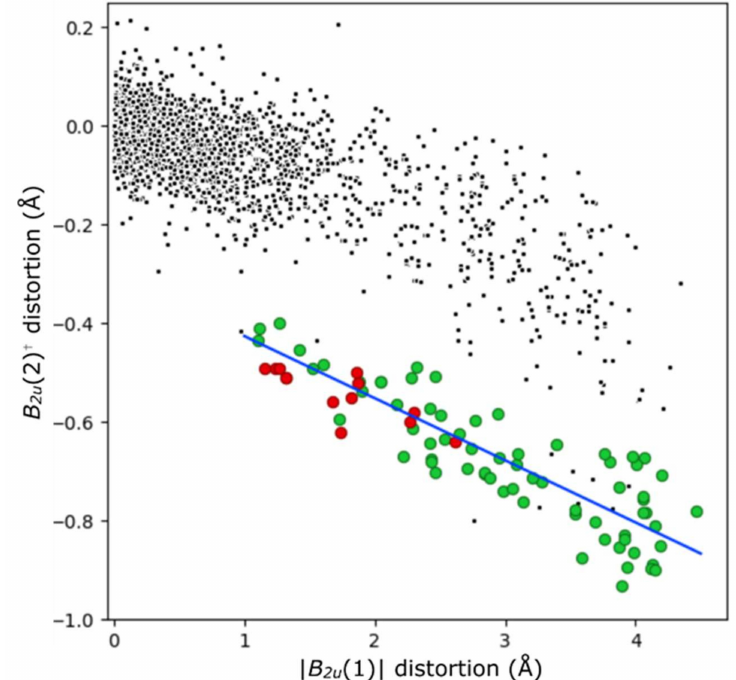
Figure 9. The B 2 u (1) and B 2 u (2) distortions in acid (H 4 ) porphyrins (green) versus non-cationic porphyrins (black) from crystal structures identified from the CSD. Saddle-shaped diacid compounds reported in this paper are highlighted in red, and the indicated least-squares relation ( B 2 u (2) † = − 0.126 ( | B 2 u (1) | ) -0.300) with a blue line. The distortion modes are shown in Figure S3.2. † (y-axis) B 2 u (2) values are multiplied by the sign of the B 2 u (1) mode; as this mode is symmetrical through the plane, subsequent modes can be aligned to